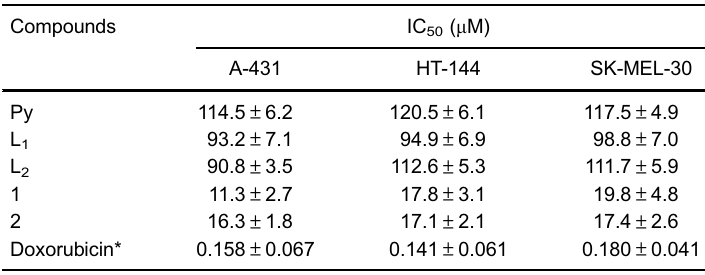
Table 2. Antiproliferative activity IC 50 ( m M) of Py 3 CoL 1 (1) and Py 3 CoL 2 (2) and their corresponding organic ligands Py, L 1 and L